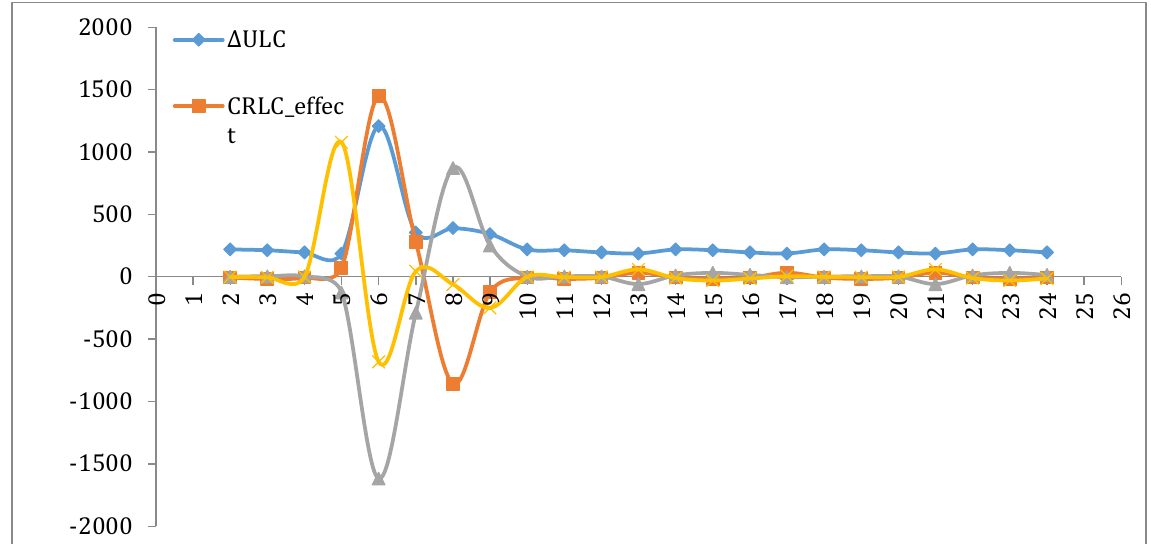
Figure 5: Quarterly change in the intensity of logistics costs and its factors